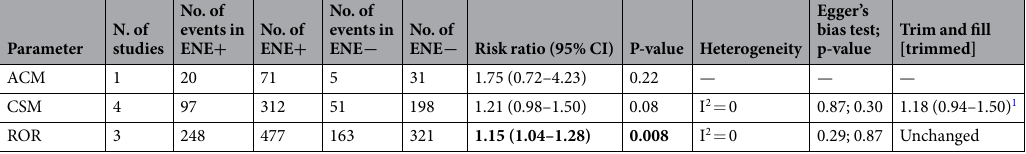
Table 1. Pooled risk ratio estimates for overall and disease-free survival by presence or absence of extranodal extension. Abbreviations: ENE: extranodal extension; CI: confidence interval; ACM: all-cause mortality; CSM: